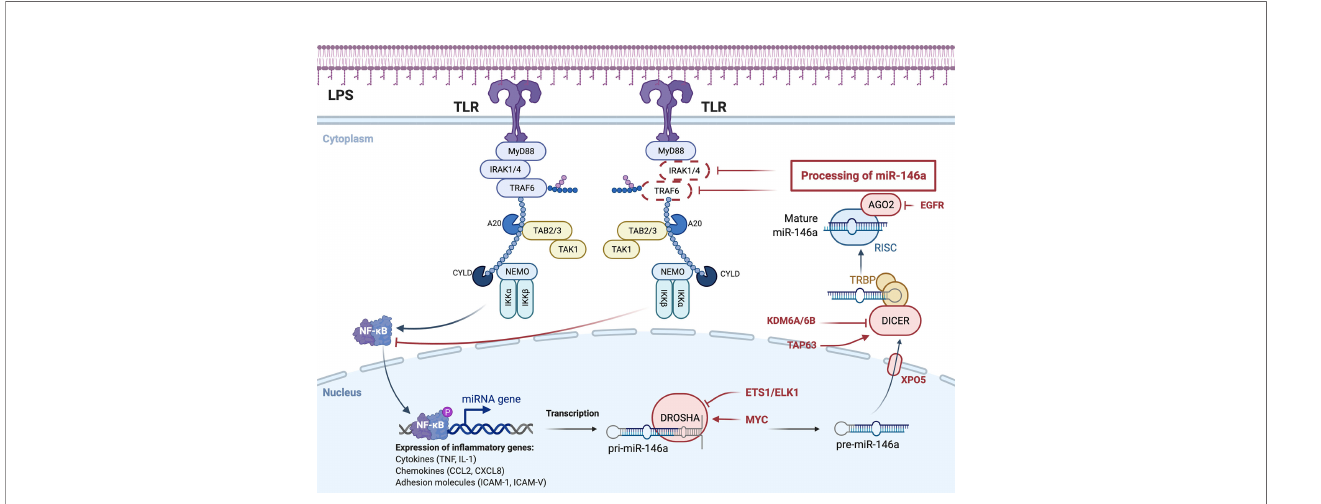
FIGURE 3 | miRNA-mediated negative feedback loop of macrophage polarization to M1 type. TLR on the macrophage cell membrane, stimulated by bacterial LPS, activates NF- k B pathway, which in turn promotes the formation of miR-146a, and the formation of miR-146a inhibits NF- k B pathway by inhibiting IRAK1 and TRAF6. Expression and function are two distinct concepts for the same miRNA family